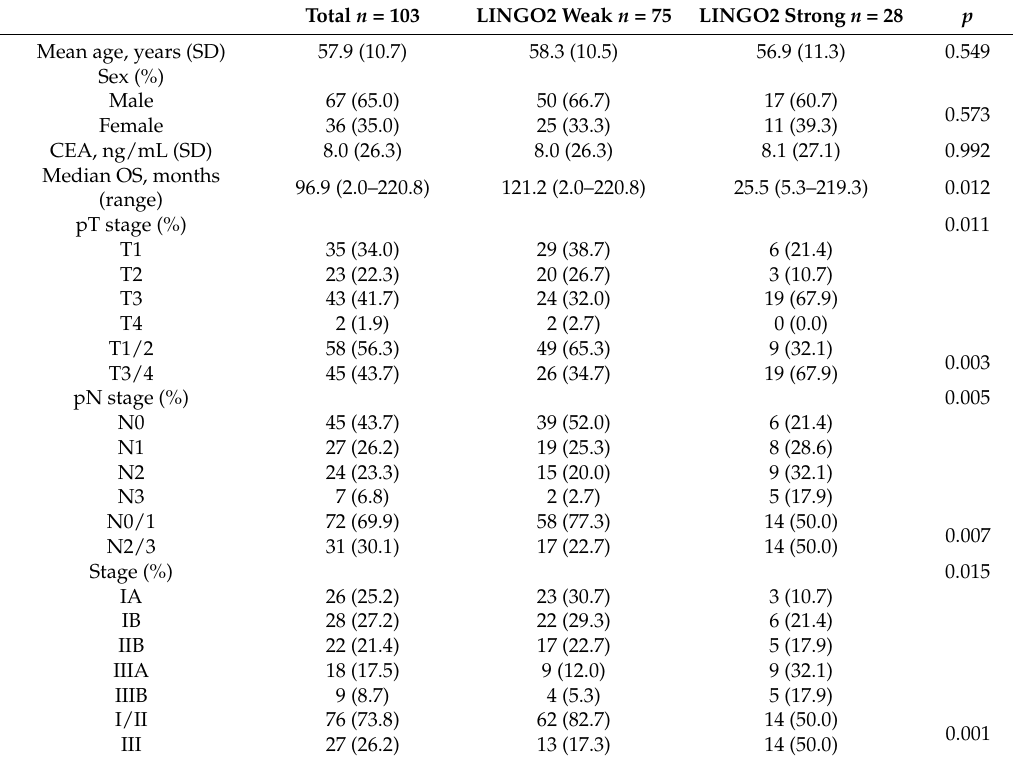
Table 1. Clinical characteristics based on LINGO2